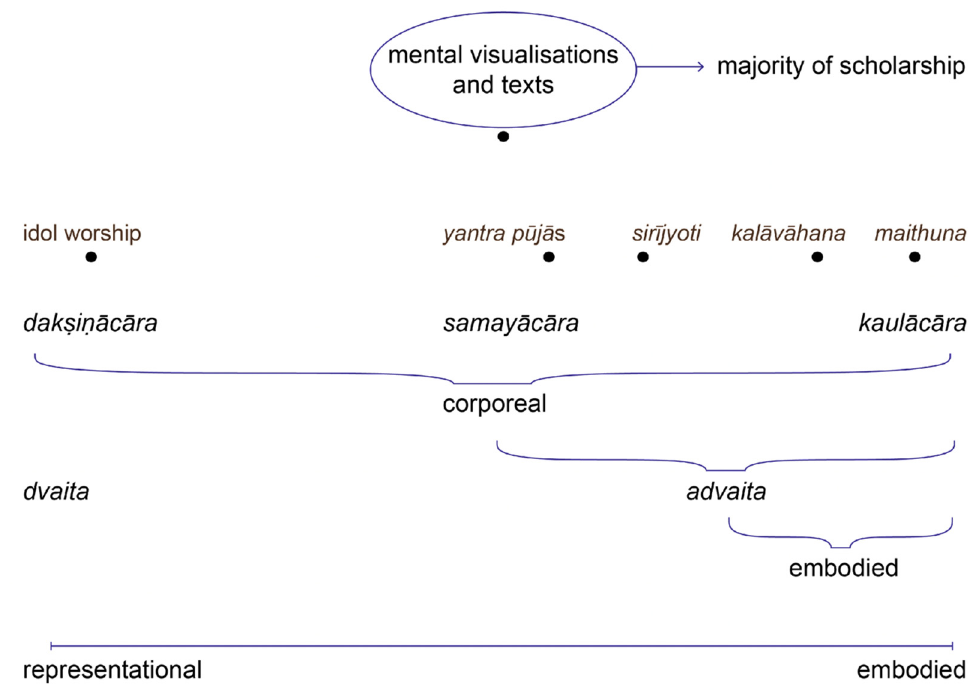
Figure 9. Representational and embodied rituals on the scale of corporeality. Credit: Nirbhay Sen. While embodiment is central to kaul ā c ā ra practices, it also marks rituals that are on